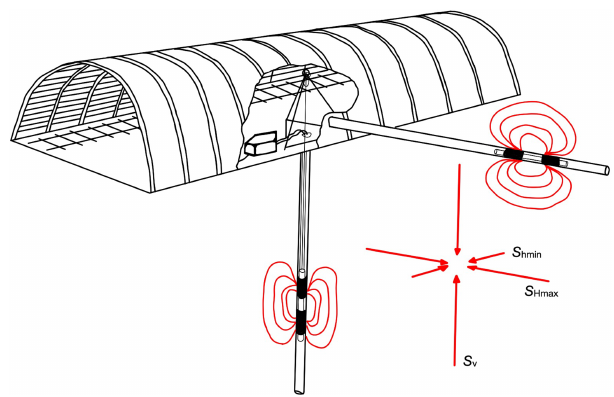
Figure 3. A schematic setup for a hydrofracturing test in a coal mine with both vertical and horizontal boreholes and induced frac- tures presented in red (modified after Kück, 1988; MeSy,